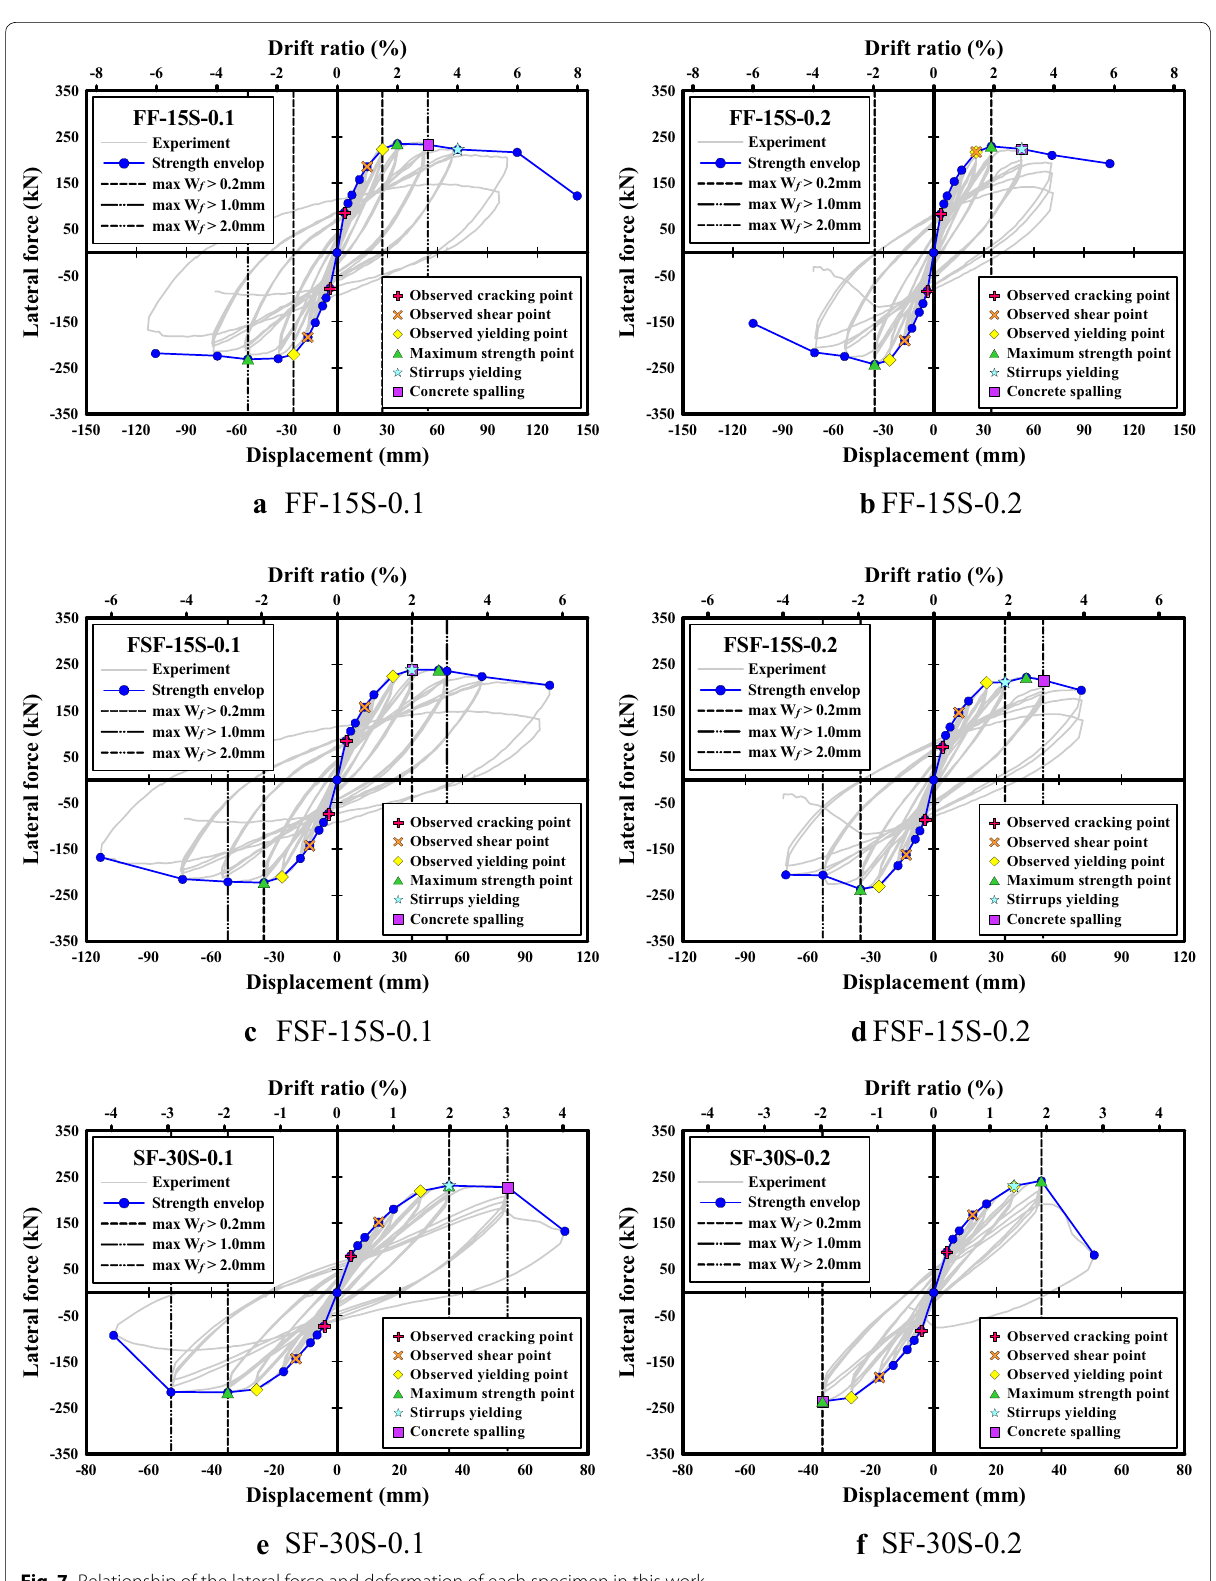
Fig. 7 Relationship of the lateral force and deformation of each specimen in this